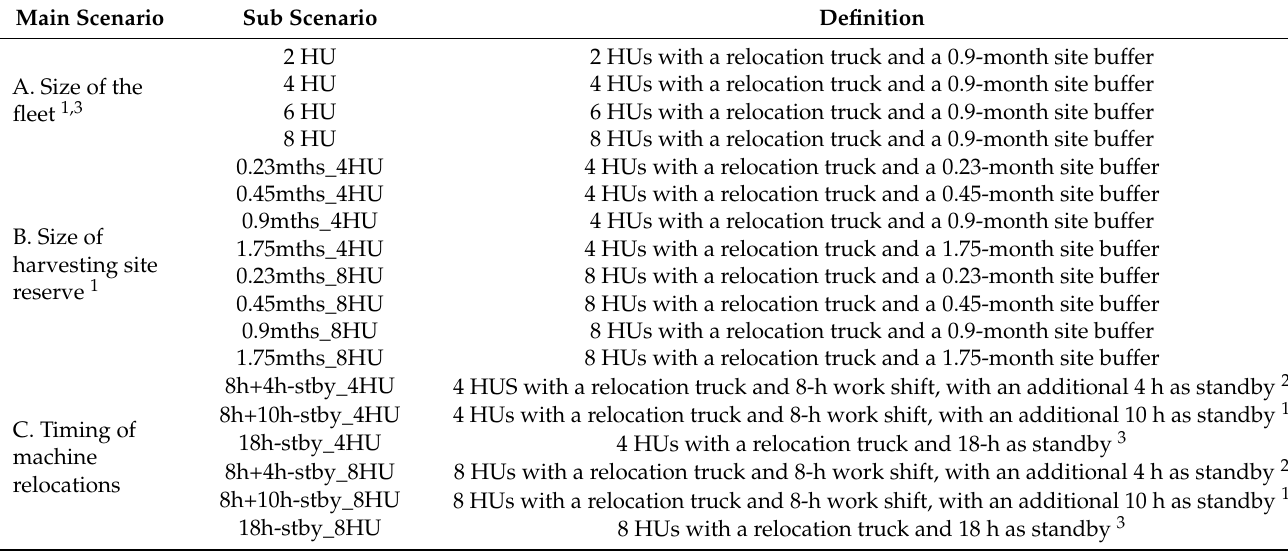
Table 7. Simulation scenarios of the